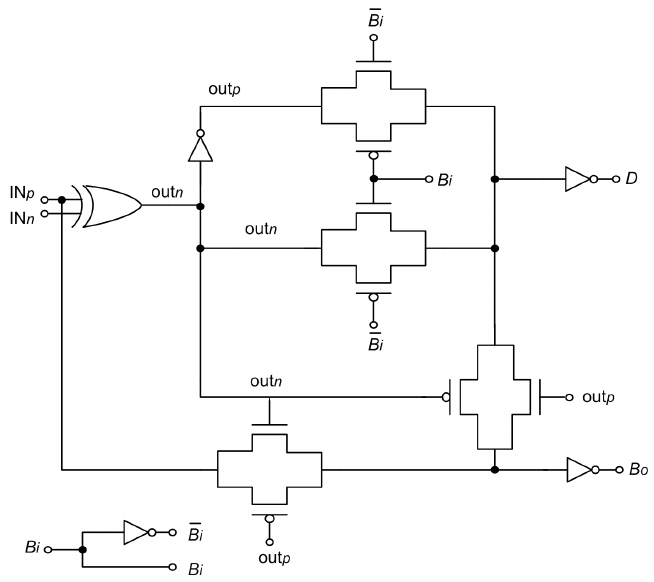
Figure 11. Transistor level implementation of a one bit full subtractor used in the proposed